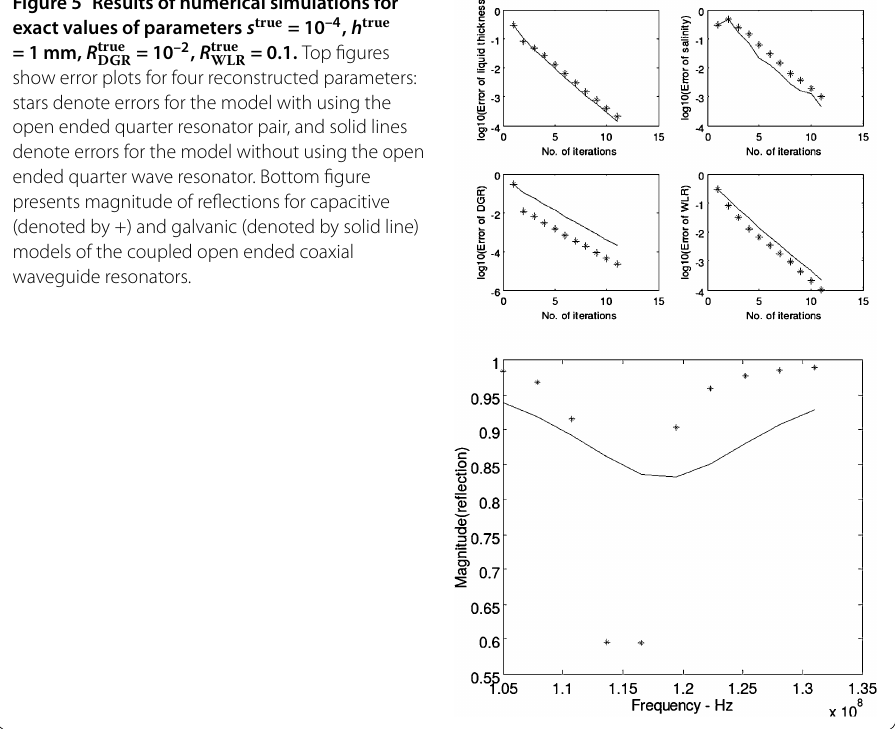
Figure 5 Results of numerical simulations for exact values of parameters s true = 10 –4 , h true = 1 mm, R true = 10 –2 , R true = 0.1. Top figures DGR WLR show error plots for four reconstructed parameters: stars denote errors for the model with using the open ended quarter resonator pair, and solid lines denote errors for the model without using the open ended quarter wave resonator. Bottom figure presents magnitude of reflections for capacitive (denoted by +) and galvanic (denoted by solid line) models of the coupled open ended coaxial waveguide